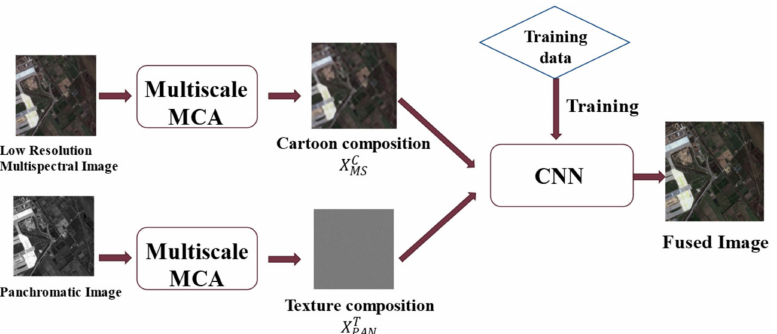
Figure 6. The flow chart of the fusion